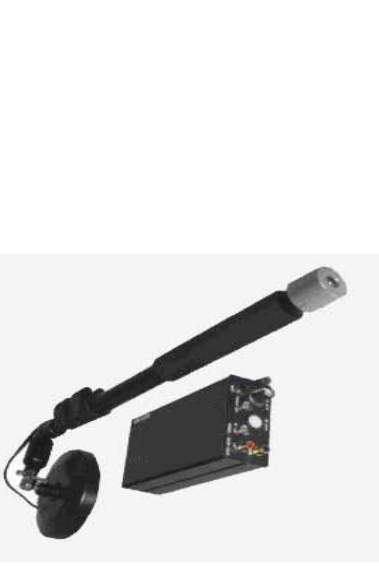
Figure 17 – Е lectronic stethoscope LIEDS 2220 Рис . 17 – Электронный стетоскоп LIEDS 2220 Слика 17 – Електронски стетоскоп LIEDS 2220